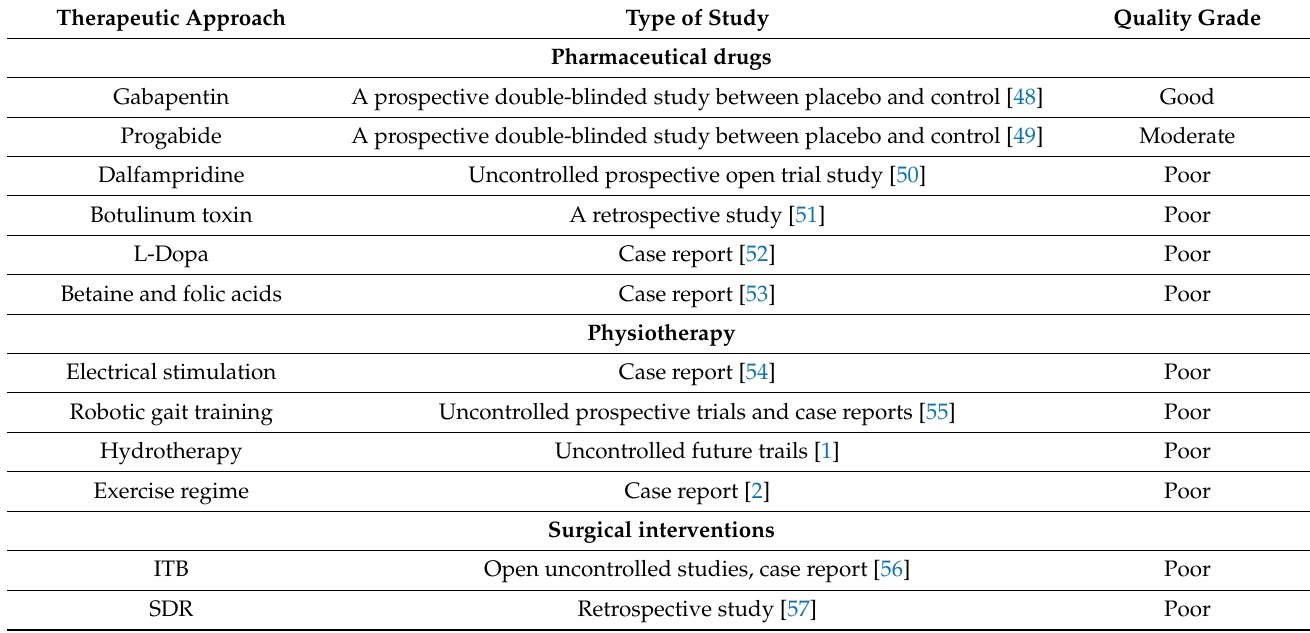
Table 1. An overview of the therapeutic and surgical approachs used in HSP management to date and the quality of the protocol used (Good—efficacious; Moderate—obtained substantial results from large cohorts; Poor—requires more clinical trials in large cohorts to ascertain the